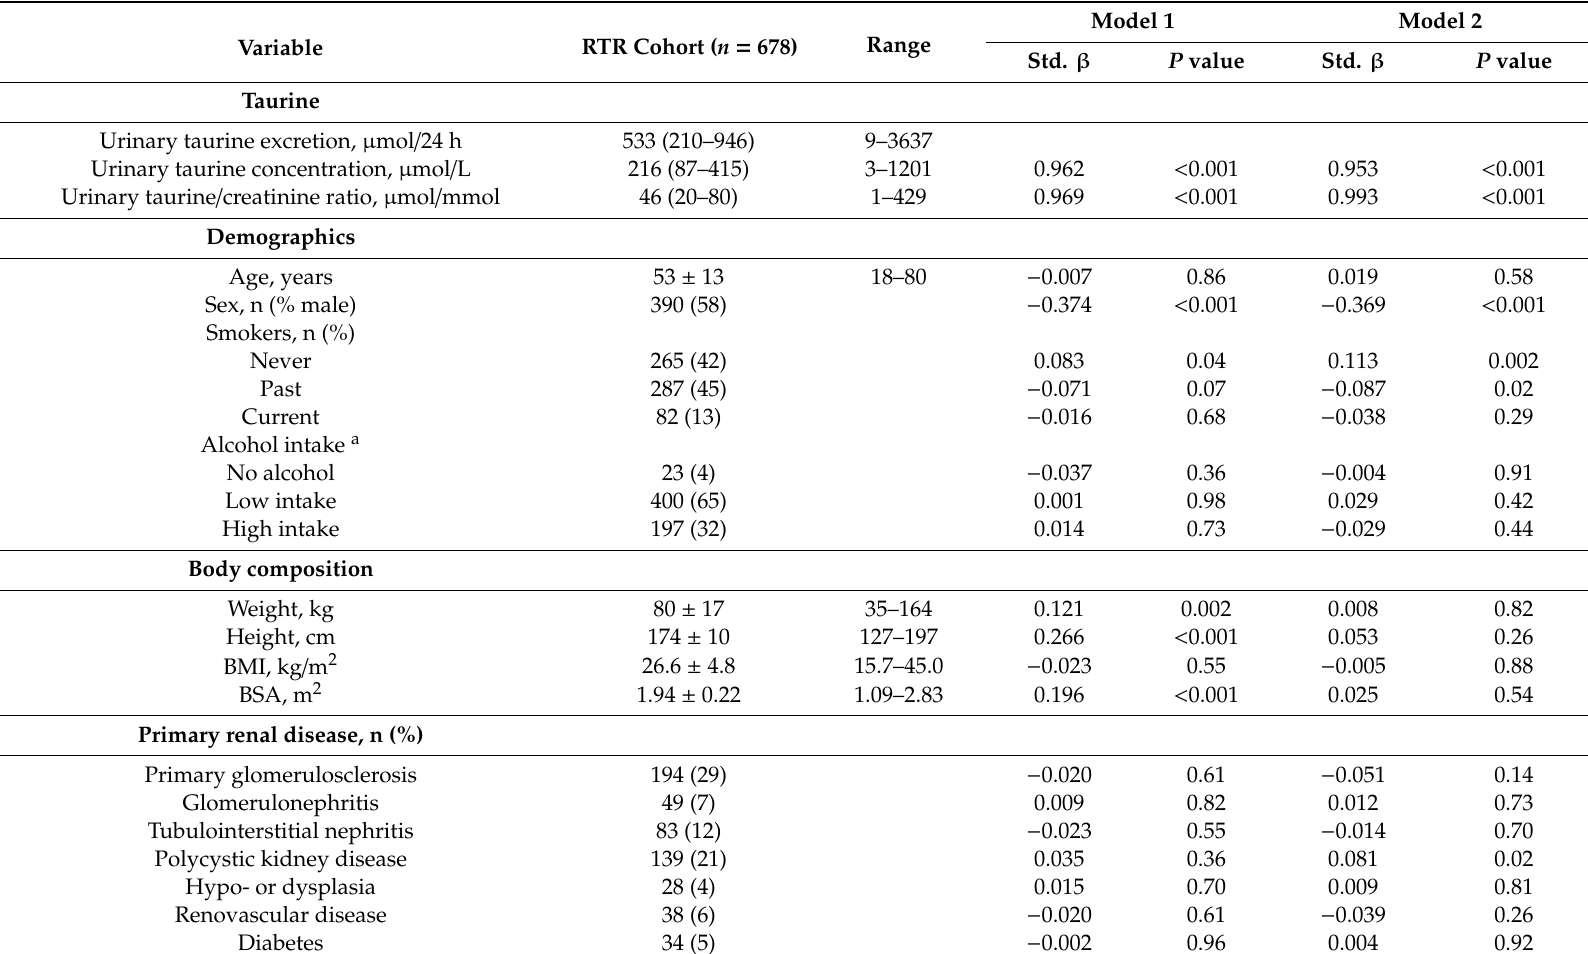
Table 1. Baseline characteristics in 678 renal transplant recipients (RTR) and regression coe ffi cients of the associations with log 2 transformed urinary taurine